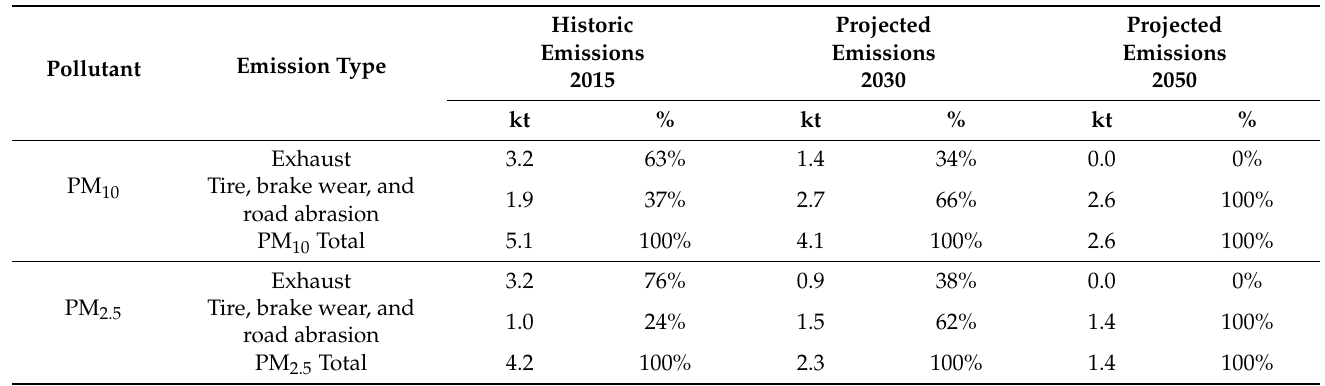
Table 2. Road transport particulate matter emissions (YJ